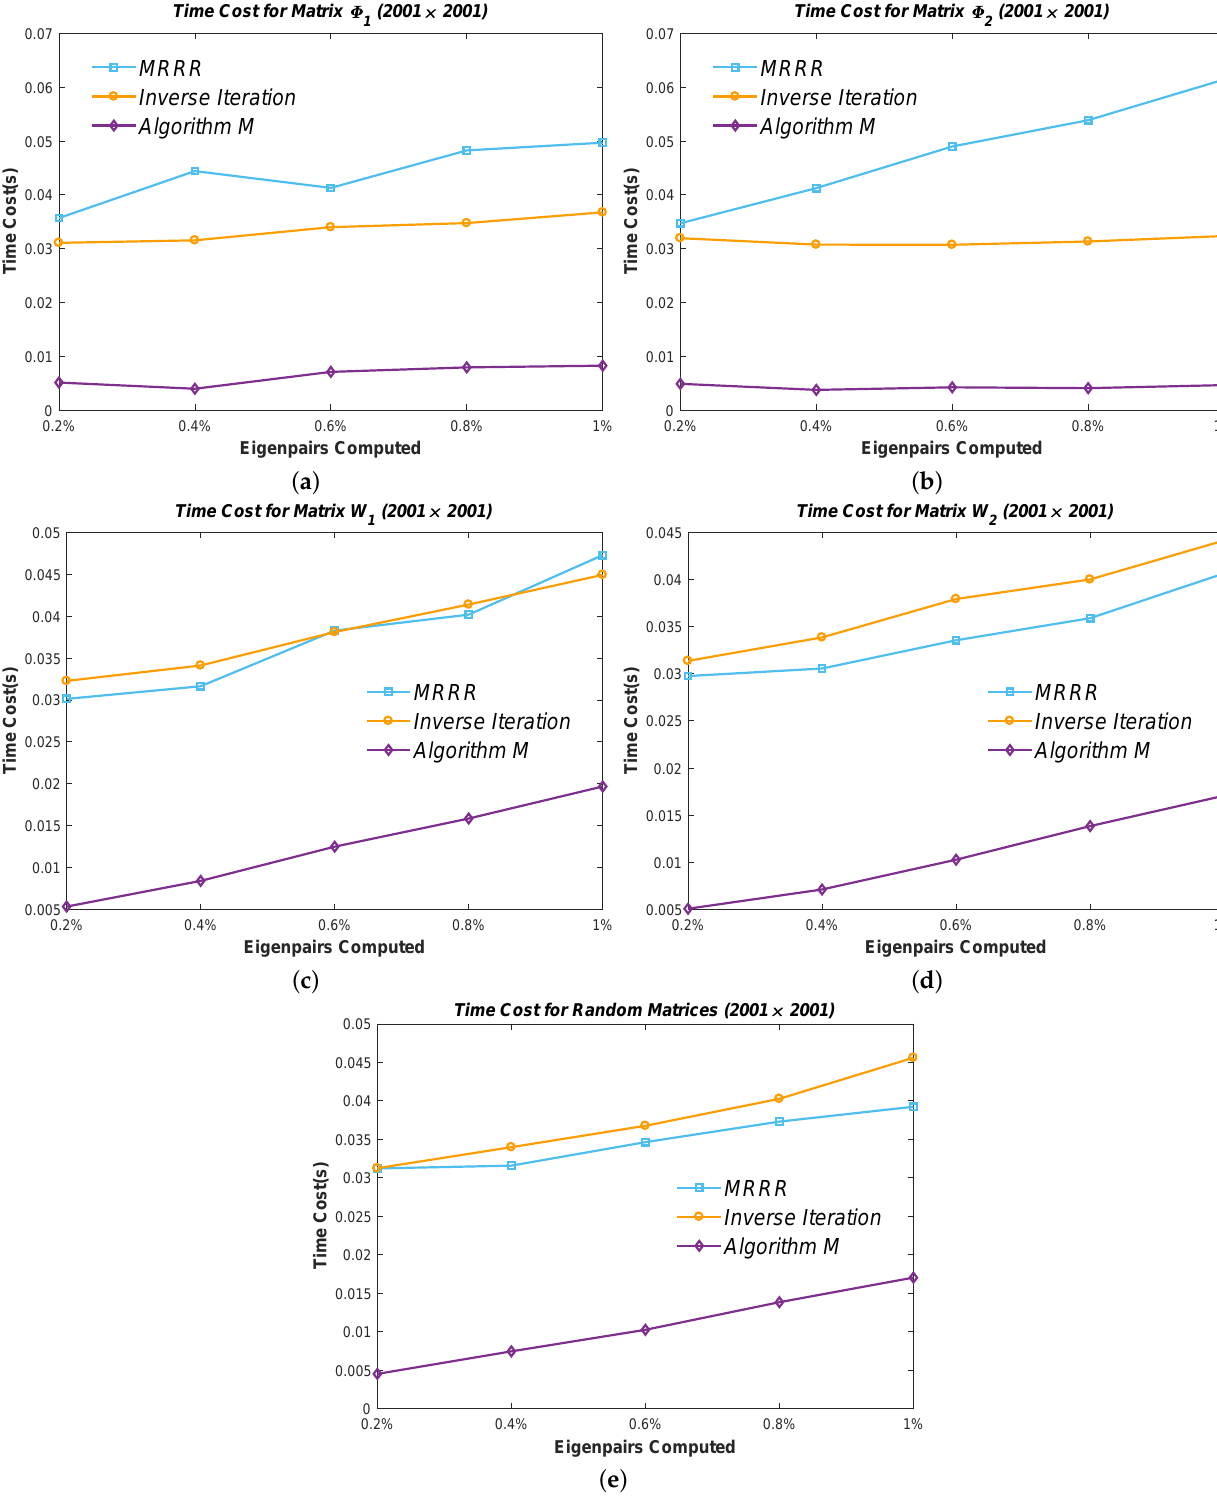
2001: ( a ) Matrix Φ 1 ; ( b ) Matrix Φ 2 ; ( c ) Matrix ×